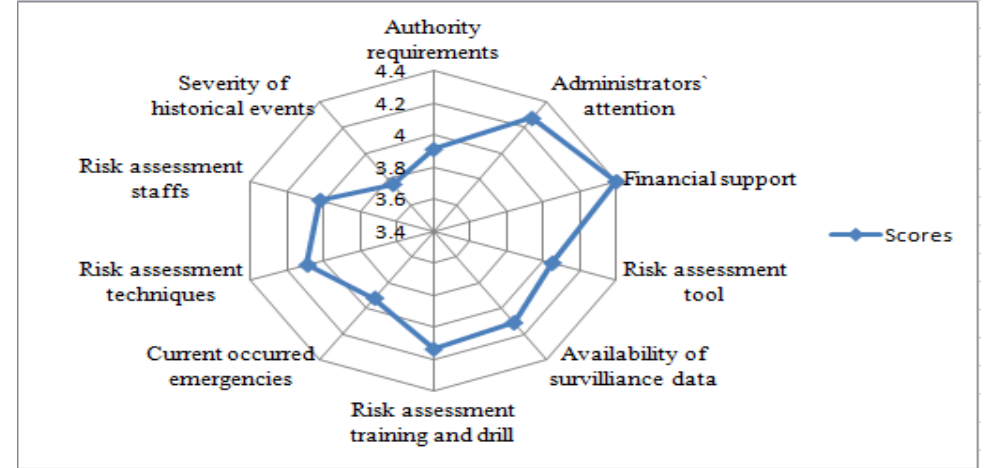
Figure 3. Importance scores of perceived factors associated with risk assessment competencies.